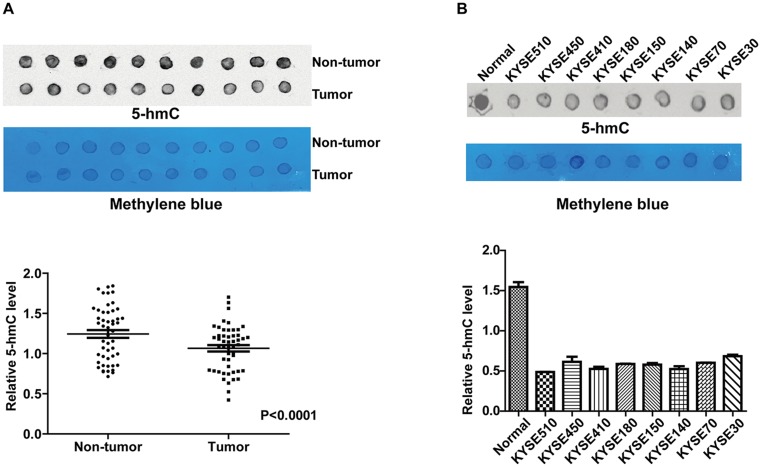
The expression of 5-hmC was decreased in ESCC tissues and cell lines.(A) Detection of 5-hmC expression in 50 matched ESCC tissues and corresponding non-tumor tissues using DNA dot blot assay. (B) Detection of 5-hmC level in 8 ESCC cell lines using DNA dot blot assay, the DNA isolated from 10 normal esophageal tissues were random selected and pooled as normal control. The methylene blue staining of 200 ng total genomic DNA was used as loading control. The intensity of the dot signal was quantified using ImageJ software, the relative 5-hmC level was calculated by dividing the value of 5-hmC by methylene blue, paired t test was used.